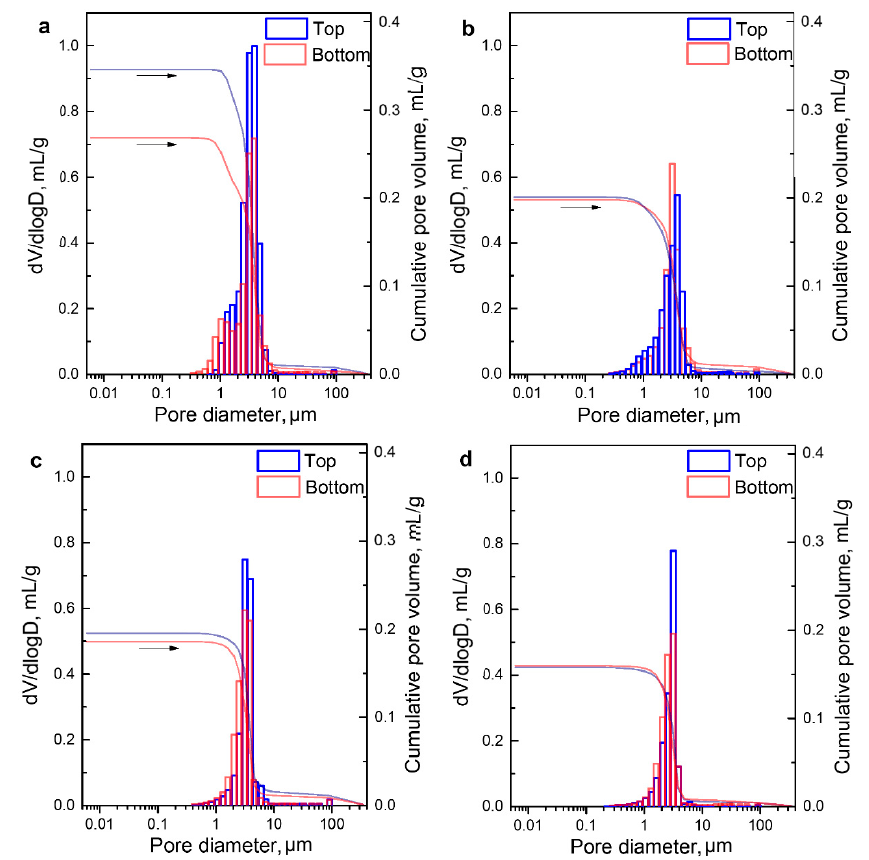
Figure 6. Pore size distribution and cumulative pore volume of the top and bottom parts of porous α -SiAlON samples fired at different conditions: ( a ): 1800 ◦ C-1 h; ( b ): 1800 ◦ C-2 h ( c ): 1900 ◦ C-1 h and ( d ): 1900 ◦ C-2